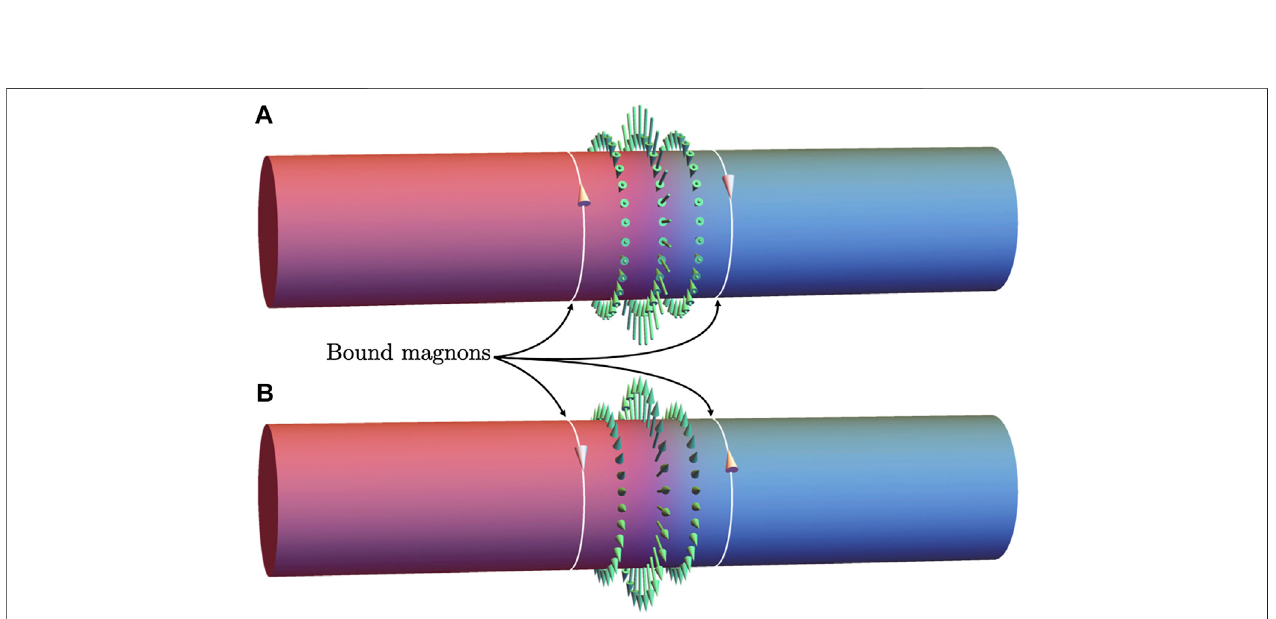
FIGURE 3 | The effective potentials V eff and their SUSY partners ~ V eff for an incoming magnon through the z -axis. The solid (dashed) lines represent the effective potential V eff ( ~ V eff ) . The black lines represent the cases of Q = 0 and the blue lines represent the cases of Q = − 1. Here, we assume that ρ = λ 0 .